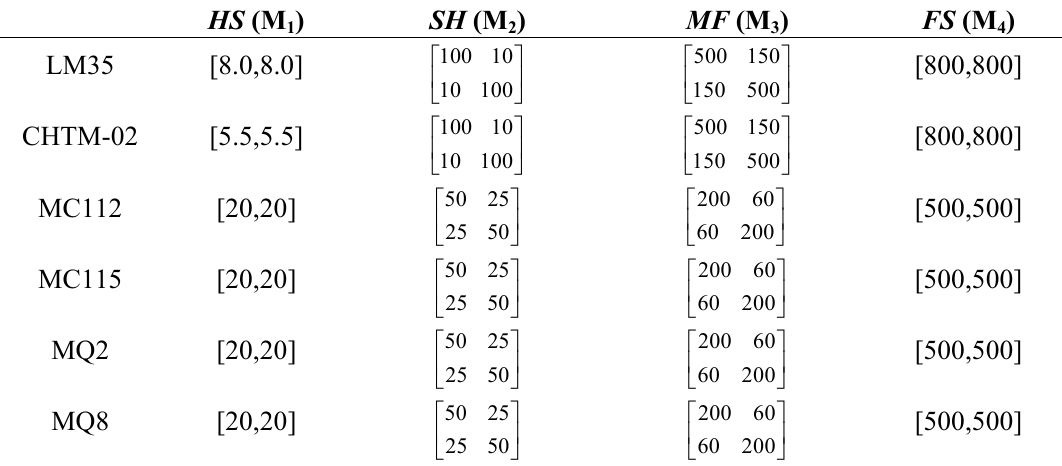
Table 5. Whitening function parameters of the grey model.